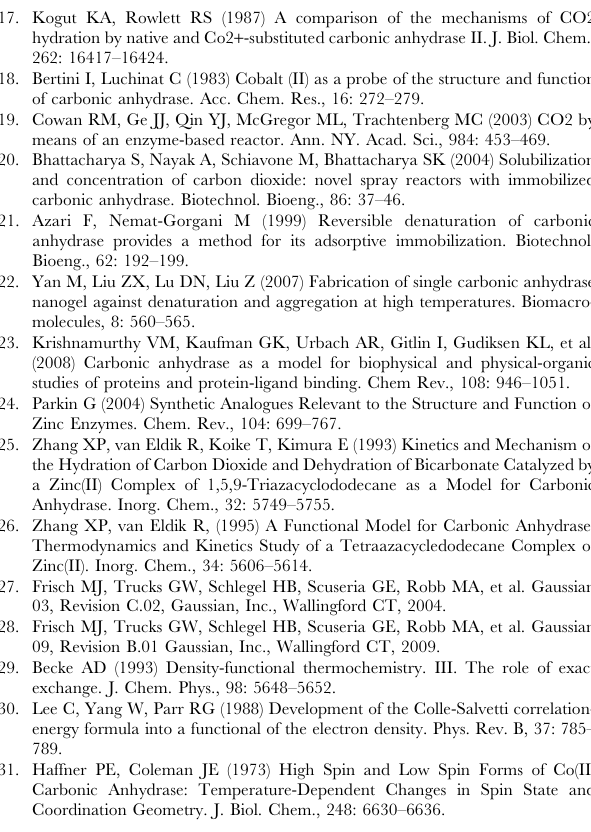
Figure S3 Optimized structures of I2 (Lipscomb intermediate) interacting with a single water molecule for N3 (A), N4 (B), Ph (C), and Ben (D), respectively. Numerical values are in angstroms. Figure S4 The interconversion of the Ph -Zn complex from I3 to I4 shown from the top view and side view. Figure S5 Comparison of calculated structures for Ph -Zn with bicarbonate and X-ray crystal structures of carbonic anhydrase II interacting with acetate. Panels (A) and (B) show wild-type carbonic anhydrase II and Panel (C) show the E106Q mutant. (TIF) Figure S6 Overlay of the wild-type human carbonic anhydrase coordinated to acetate (1CAY, green) and the mutant T199A of human carbonic anhydrase coordinated to bicarbonate (1CAM, cyan). Figure S7 Measured initial rate of Zn-STBI (sulfonated- Ben ) and Zn-Cyclen ( N4 ) in TAPS buffer at 25 u and 50 u C for CO 2 hydrolysis reaction. Figure S8 X-ray crystal structures of the active site of Zn-Cam (1QRL) and Co-Cam (1QRE) binding bicarbonate, are shown in (A) and (B), respectively. Numerical values are the oxygen to metal distances and are in angstroms.